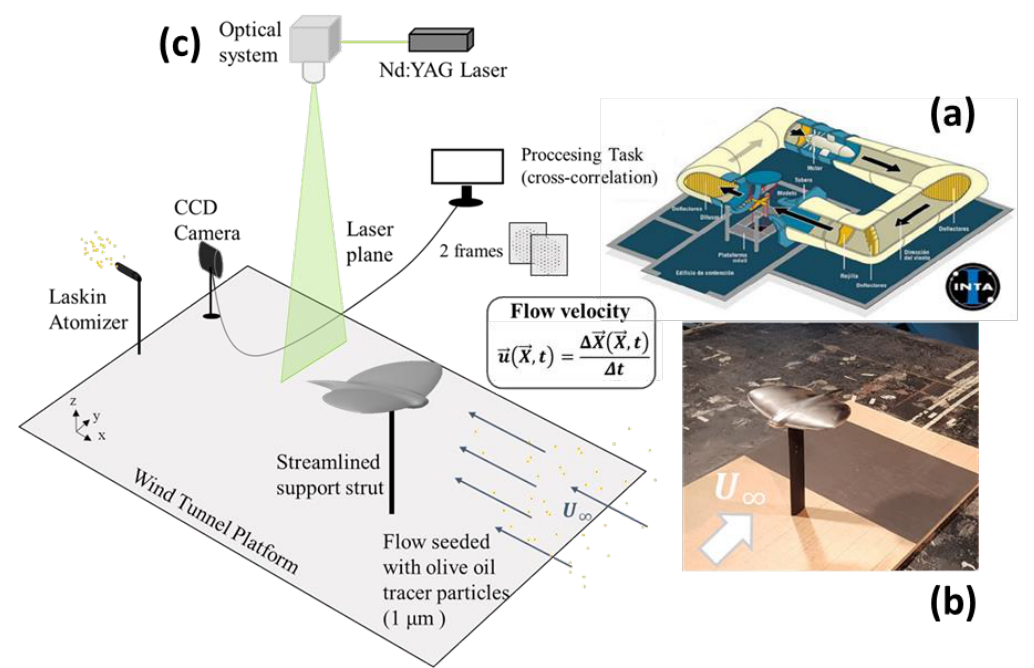
Figure 12. Low-Speed Wind Tunnel ( a ), scaled model inside the wind tunnel test section ( b ) and Particle Image Velocimetry set-up ( c ).